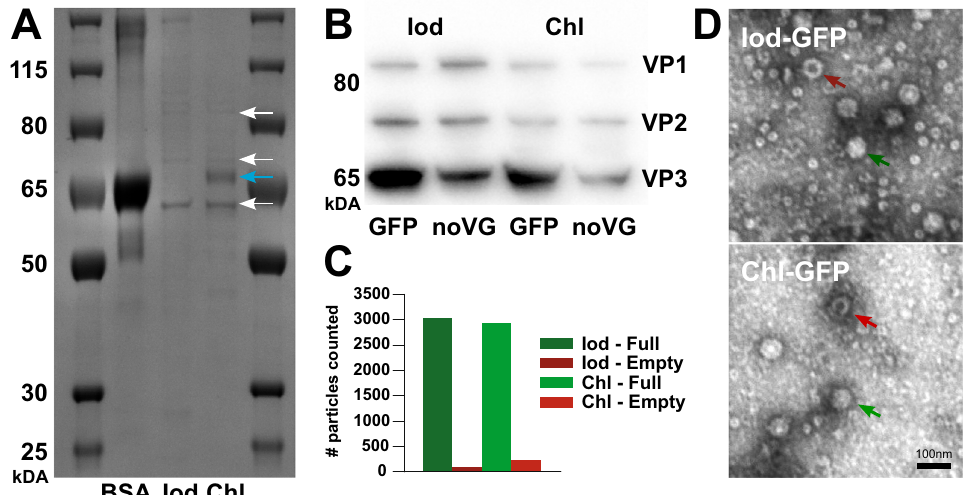
Figure 2. Total protein levels and capsid assessment. ( A ) Coomassie blue gel displaying protein-weight distribution of the two AAV-GFP vectors produced with the Iodixanol-gradient and the Chloroform- precipitation method compared to a BSA control. The bands expected for the three capsid proteins are highlighted with white arrows and the molecular weight for BSA is highlighted with a blue arrow. ( B ) Western- blot for the three capsid proteins VP1, VP2 and VP3 for the four groups containing viral capsids. Figures A and B are cropped to highlight the relevant information. Full sized gels are presented in Supplementary Fig. S1. ( C ) Bar graph displaying the number of full and empty capsid particles counted. ( D ) TEM images displaying empty (red arrows) and full capsids (green arrows) for either production method.